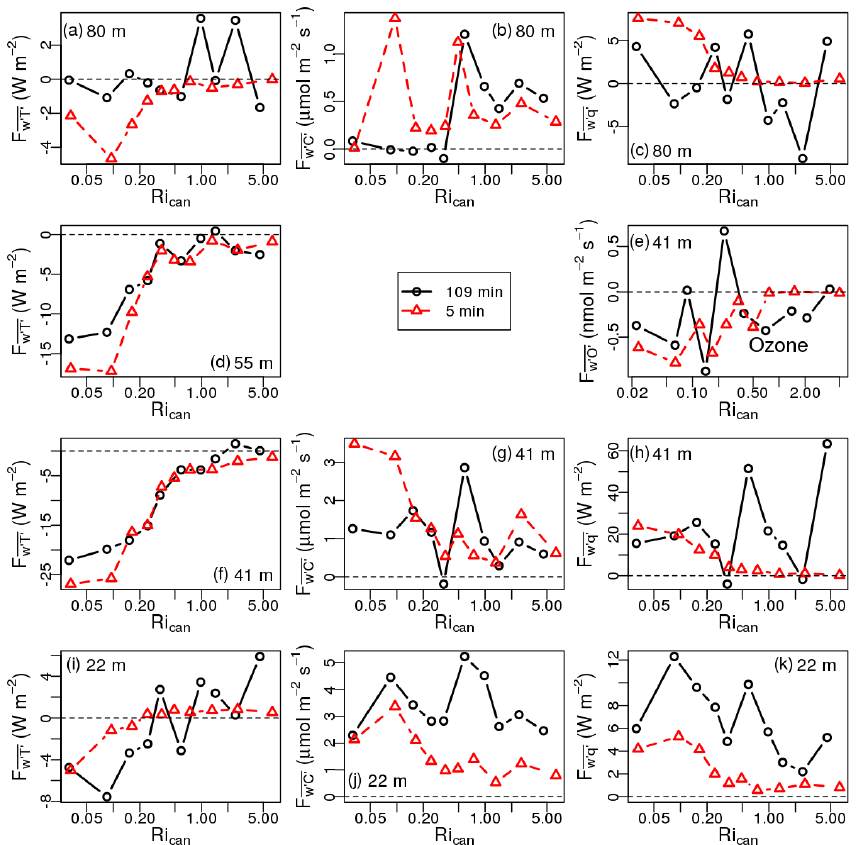
Figure 9. The dependence of sensible heat ( a , d , f , i ), CO 2 ( b , g , j ), O 3 (e) , and latent heat ( c , h and k ) fluxes on canopy Richardson number (Ri can ) for all levels, as indicated in each panel. Fluxes have been determined with 5min (red lines, triangles) and 109min (black lines, circles) time